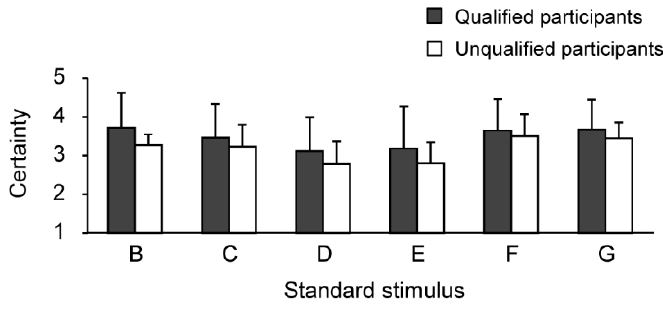
Figure 6. Levels of certainty for each standard stimulus. Table 2. Results of teachers’ and beginning learners’ correct answer rate.